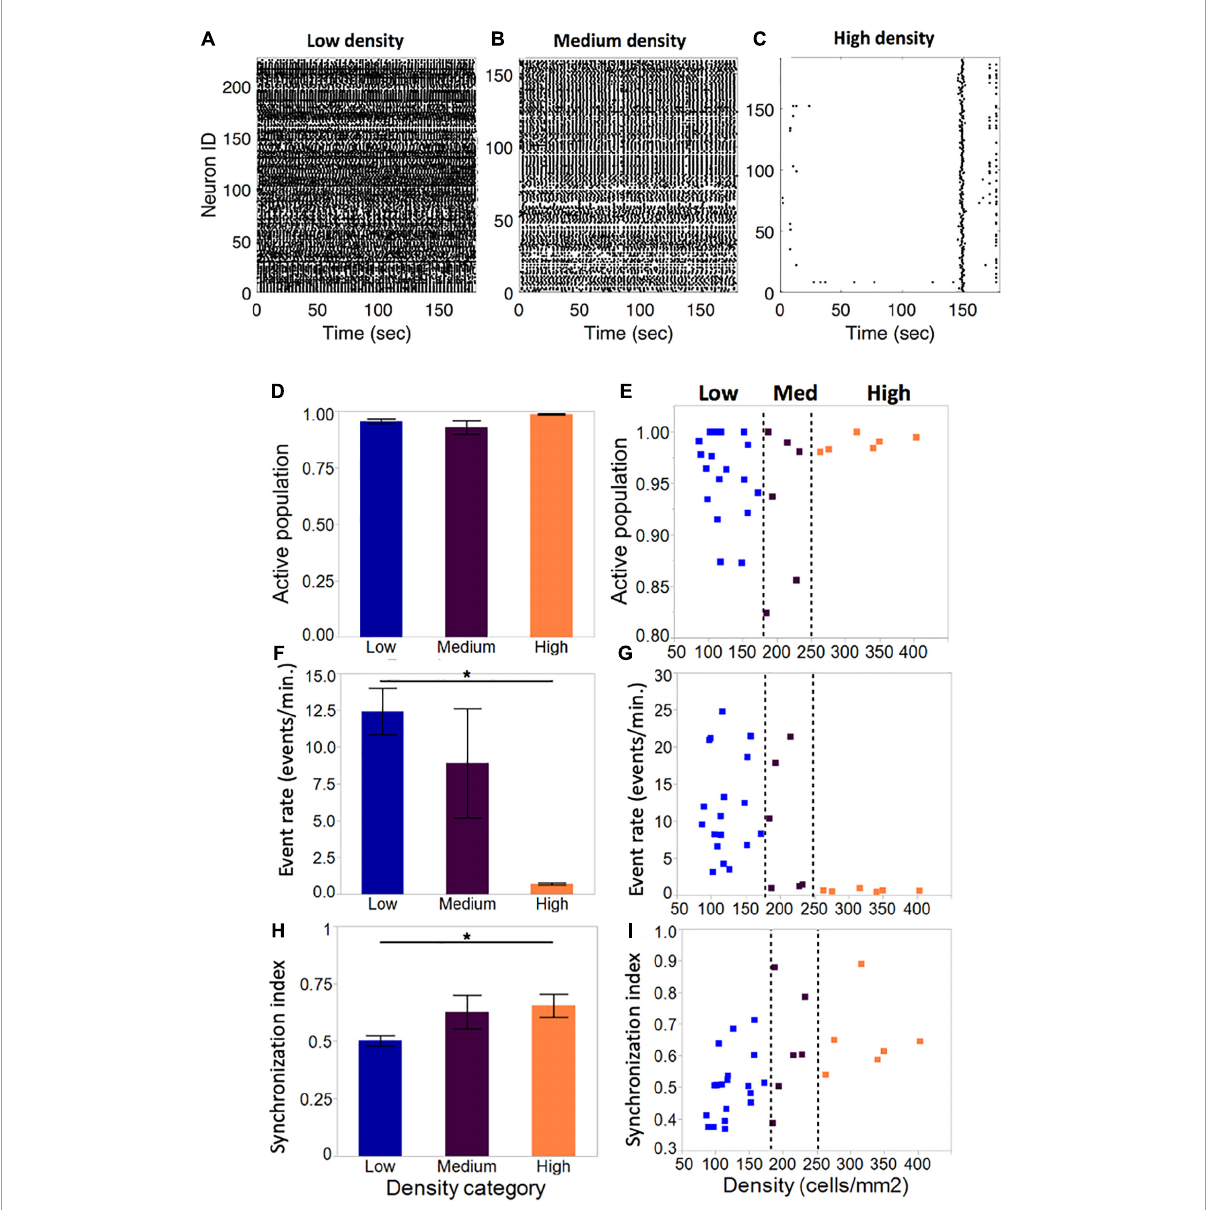
FIGURE4 Activity metrics in neuronal islands of varying cellular densities (A–C) . By DIV 10, the vast majority of neurons in islands were functionally integrated in spontaneous Ca 2 + events, independent of the cellular density of the culture (low: n = 19; medium: n = 6; high: n = 6). (F,G) Event rate, defined as the average number of distinct calcium transients in the island per neuron per minute, decreased significantly as cellular density increased. Averages for each category were computed as a mean of the single-cell event rates of all of the cells within a given category. (D,E) Activity became increasingly coordinated as cellular density was increased. (H,I) The distribution of island samples was more variable in low-density and medium-density islands for both the fraction of population that was active, as well as the average island event rate, with an apparent threshold of cellular density (250 cells/mm 2 ) which biased islands to a state of low-rate, highly synchronous activity. No threshold effect was observed in the distribution of synchronization index values. Significance level for statistical testing was set at 0.05 (* p < 0.05).